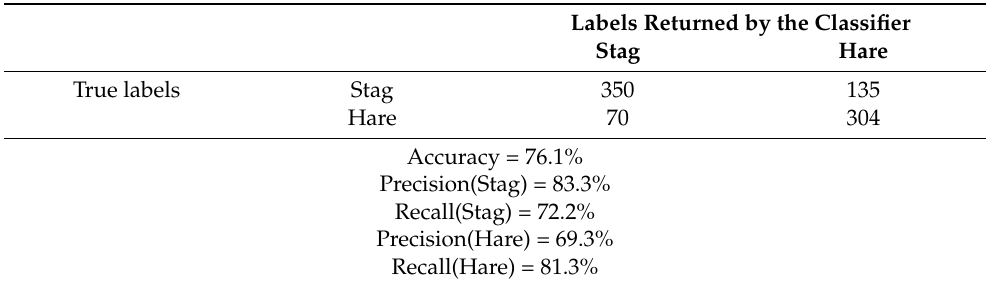
Figure 2. This decision tree shows the characteristics of stag and hare hunter students. Personality dimensions are the primary predictor of stag and hare hunting behavior. Table 8. A confusion matrix was employed to determine the accuracy and precision of the model shown in Figure 2.